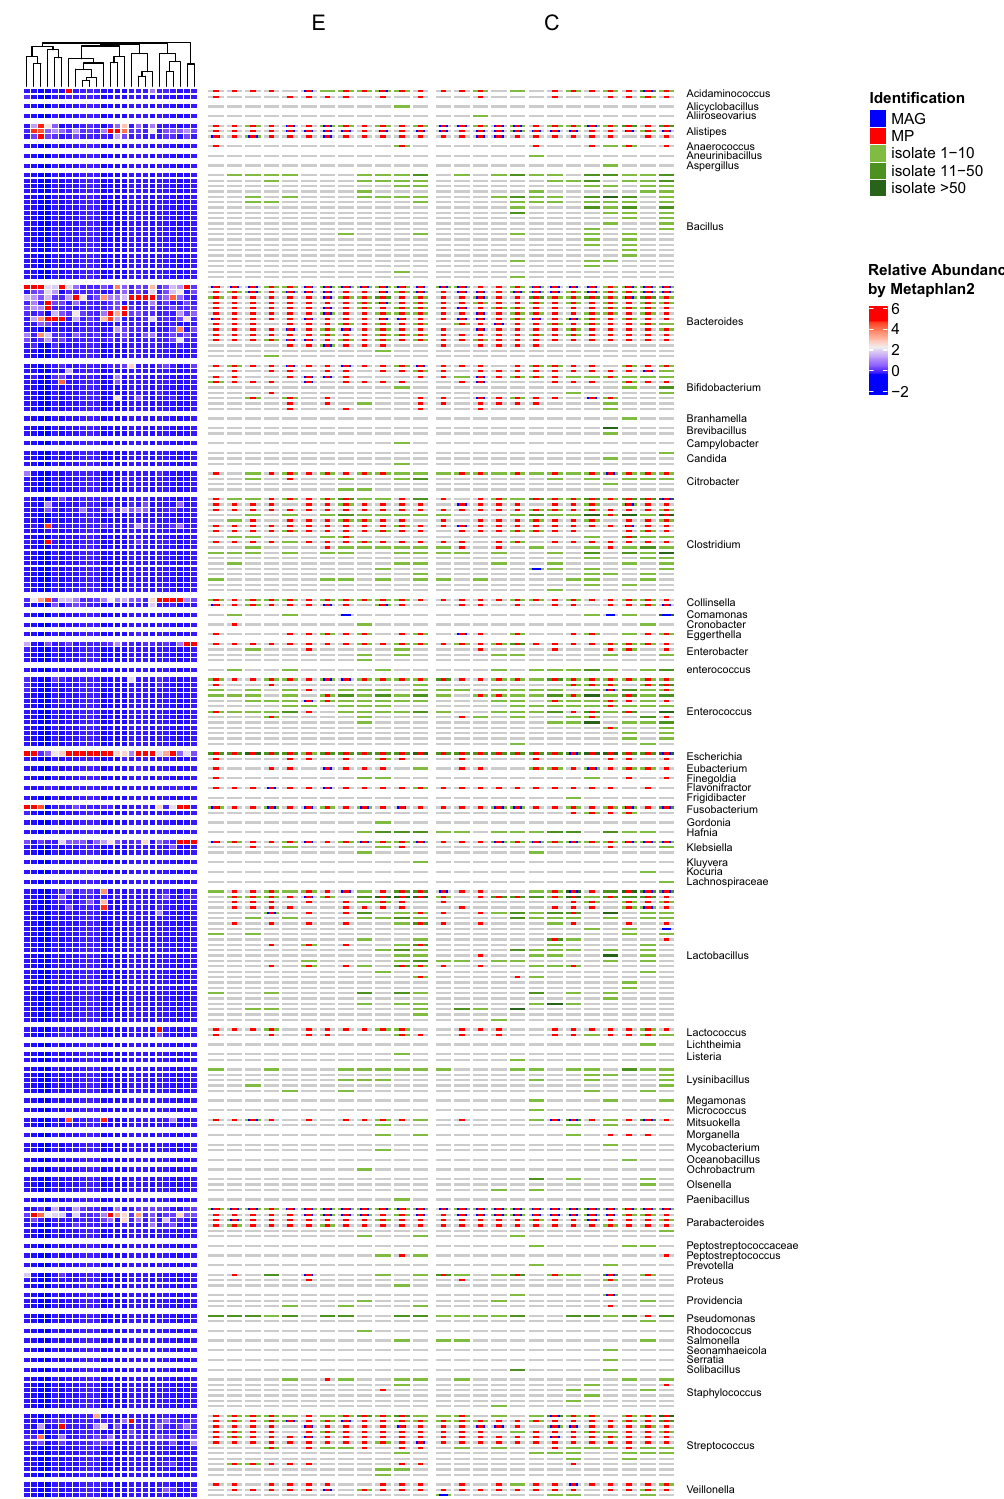
Fig. 9 Overview of the isolated strains by culturomics. The right part displayed the isolated strain number of each species in the feces donated by Hainan centenarians ( C ) and non-centenarian elders ( E ). The left part indicates the relative abundance (%) of each species in fecal samples by metagenomic